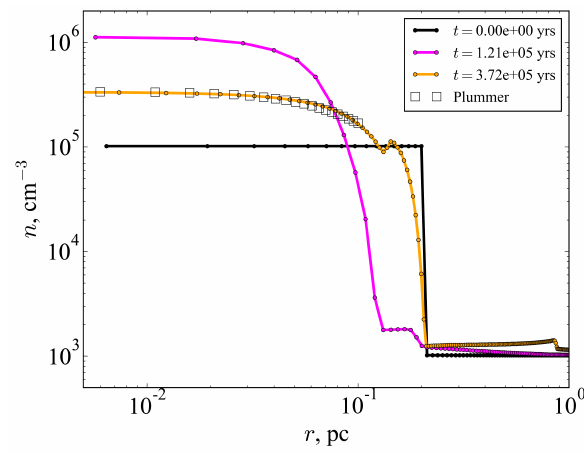
Figure 3. The n ( r , z = 0) dependences for the adiabatic cylinder with magnetic field at t = 0 (black), t = 1.21 × 10 5 yrs (magenta) and t = 7.72 × 10 5 yrs (orange) after the beginning of the collapse. Blanck squares depict a Plummer-like function (14) with p = 2, r 0 = 0.1